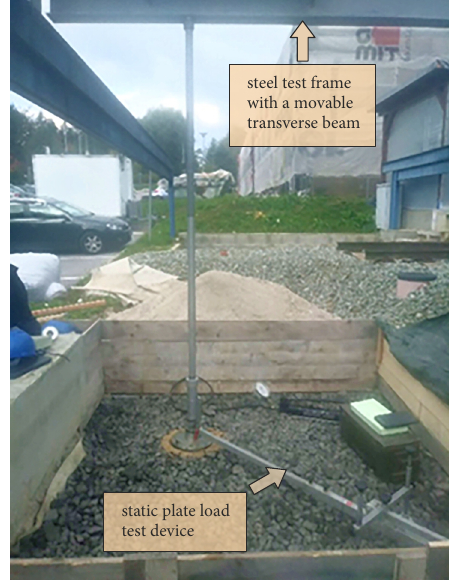
Figure 2. Implementation of static load test on the